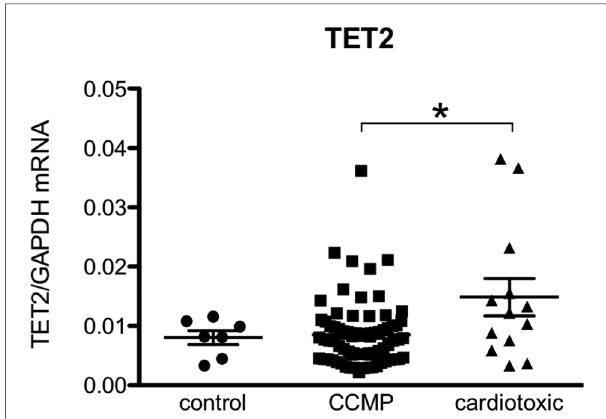
FIGURE 4 TET2 levels are more elevated in the hearts of patients with anthracycline-induced heart failure compared to non-ischemic non- cardiotoxic cardiomyopathy counterparts. Control patients are patients who underwent CABG but had no structural heart disease and normal left ventricular function (biopsy was procured upon cardiac surgery). CCMP patients are patients with non-ischemic idiopathic cardiomyopathy in whom cardiotoxicity and structural disease e.g., amyloidosis was excluded. Cardiotoxic patients are patient in which a clear link between heart failure and the previous use of anthracycline-based chemotherapy was demonstrated. *Means p <0.05 in one-way